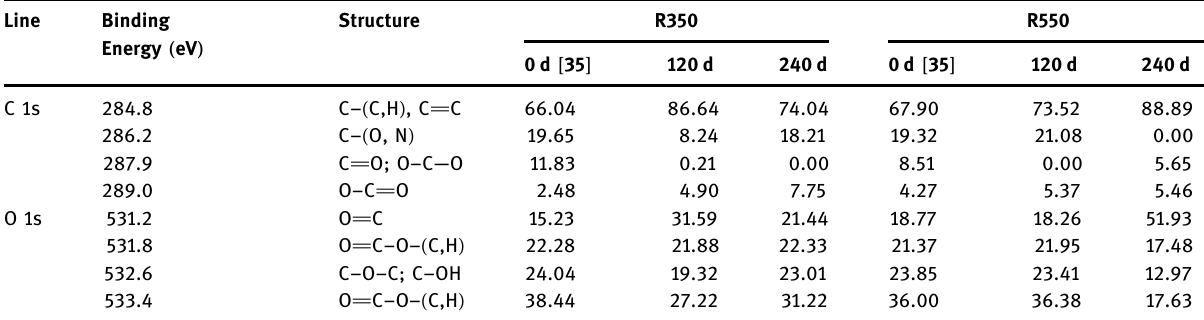
Table 4: C 1 s and O 1 s bonding states and relative atomic percentages on the biochar surfaces